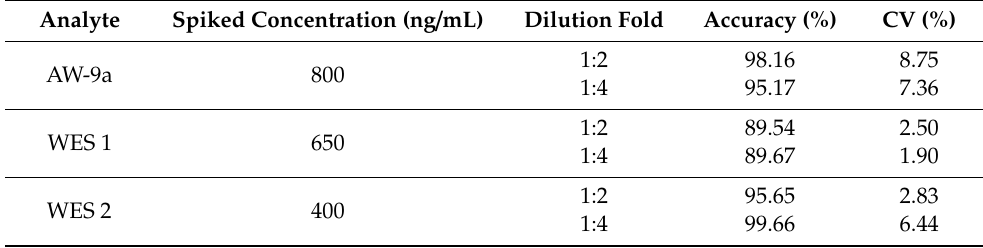
Table 5. Evaluation of the dilution integrity of AW-9a, WES-1, and WES-2 in human plasma. Analyte Spiked Concentration (ng /